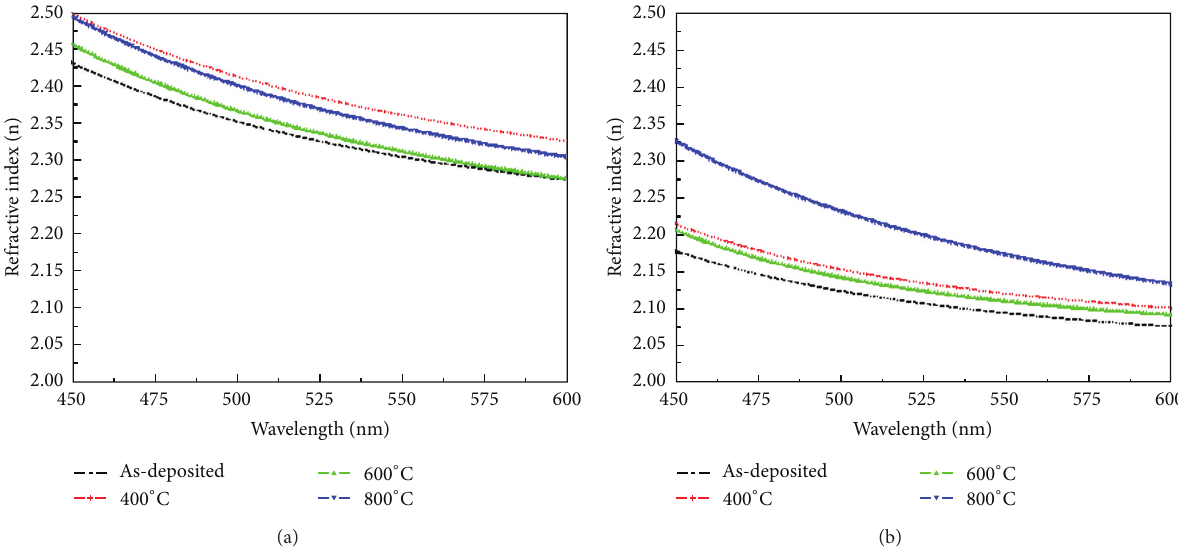
Figure 2: Refractive index obtained from (a) Ti 3 O 5 and (b) TiO 2 starting materials at various thermal annealing